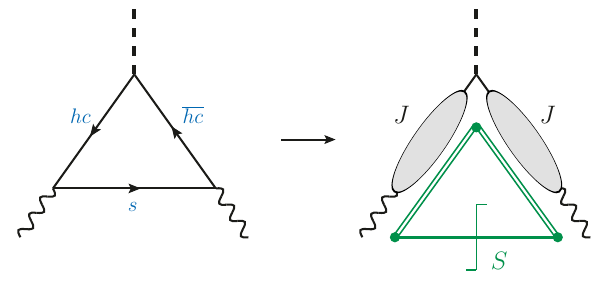
Figure 4 . Factorization of the matrix element h O 3 i in